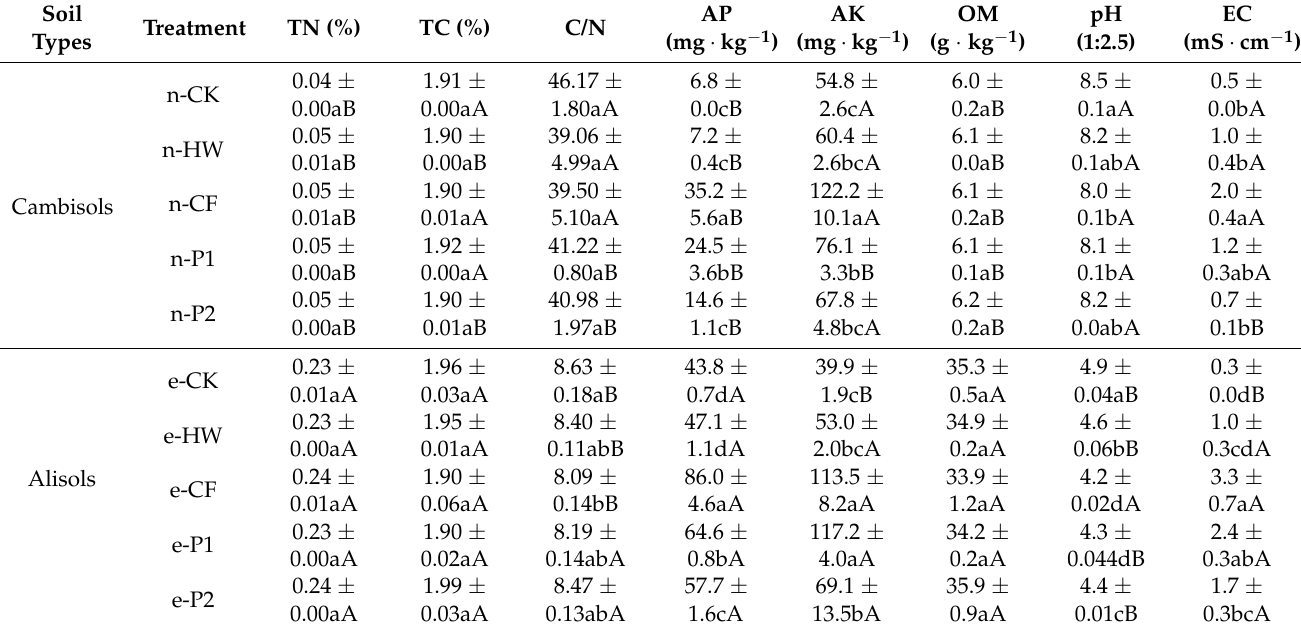
Table 2. Soil chemical